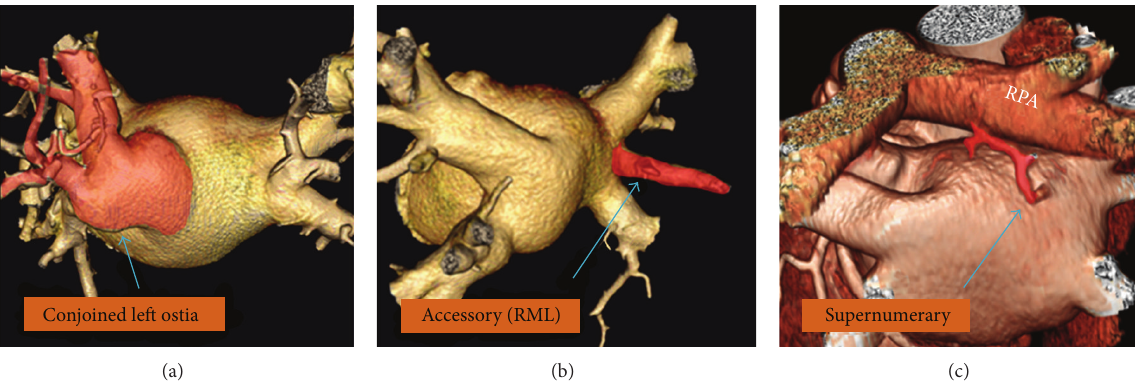
Figure 4: Anatomical variations of the pulmonary veins. Accessory right middle lobe (RML) and conjoined ostia are common and are seen in one fourth of studies. Accessory branches on the left side are not common. Supernumerary branch is usually a small branch found in 5–10% of chest studies. It usually drains the posterior segment of the right upper lobe and consistently travels behind the right main bronchus before entering the left atrium. Rarely, supernumerary branch arises from the superior segment of the right lower lobe and directly connects to the posteroinferior margin of the left atrium. Note close relationship of the right pulmonary artery (RPA) and the superior wall of the left